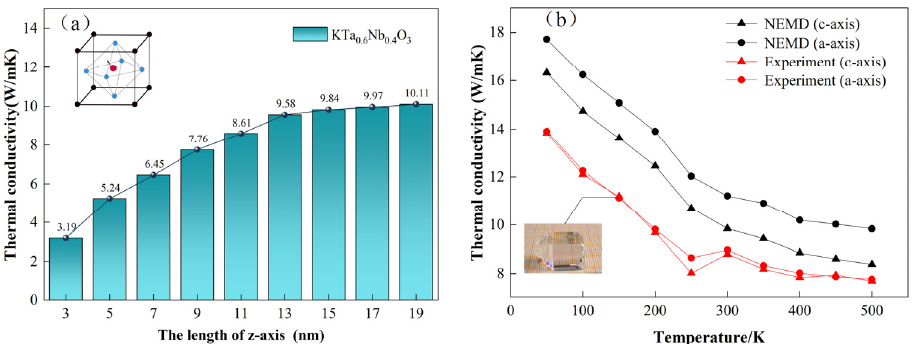
Figure 3. ( a ) Length-dependent thermal conductivity of monodomain ferroelectric KTN crystal with spontaneous polarization. ( b ) Temperature-dependent thermal conductivity of ferroelectric KTN crystal along c - and a -axis. Both calculated and experimental results are provided and compared.